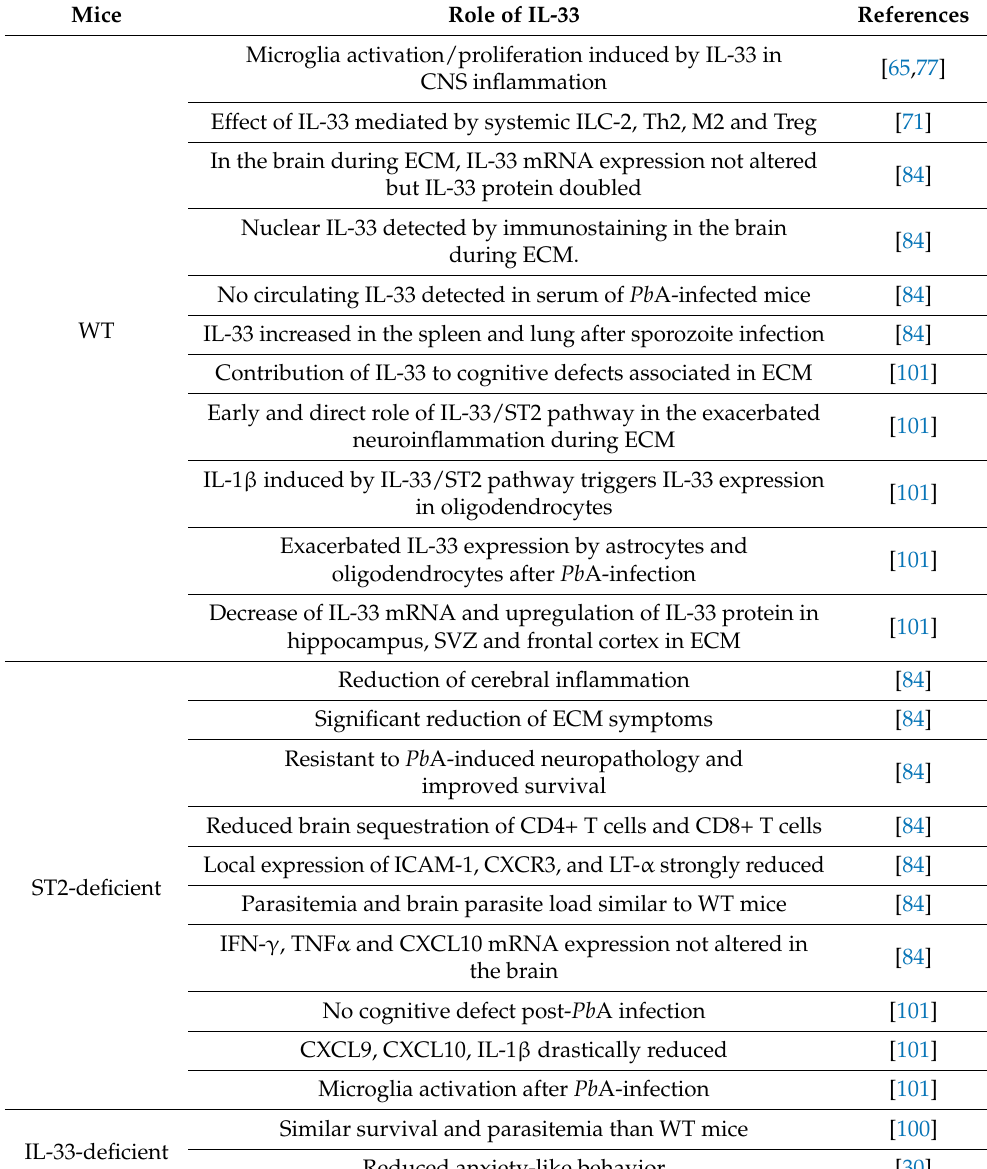
Table 1. Role of IL-33/ST2 pathway in PbA-infected mice models.